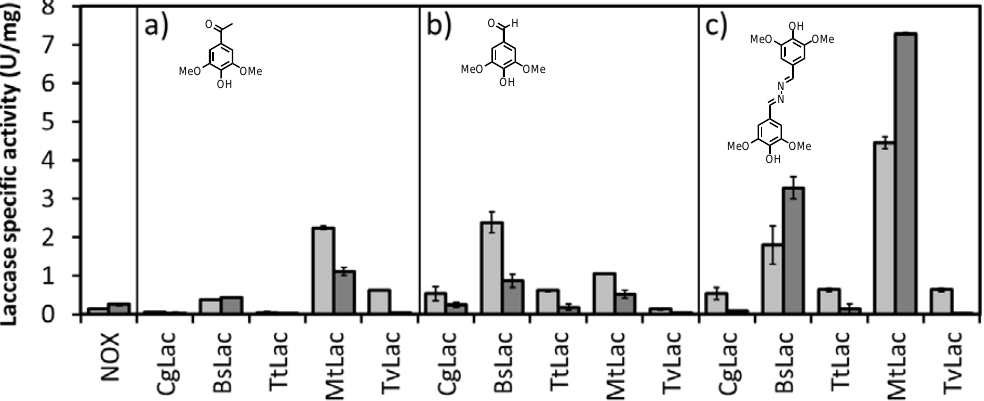
Figure 2. Screening of different laccases in combination with ( a ) acetosyringone, ( b ) syringaldehyde and ( c ) syringaldazine. The activities of the different laccase/mediator systems were spectrophotometrically assayed at pH 5.0 (light grey) and pH 8.0 (dark grey) following the decrease of absorbance at 340 nm (NADH oxidation). Activity of NOX in presence of 0.5 mM NADH at pH 5 and pH 8 is reported in the firsts two columns. Laccases from Casuarina glauca ( Cg Lac), Bacillus subtilis ( Bs Lac), Trametes trogii ( Tt Lac), Myceliophthora thermophila ( Mt Lac) and Trametes versicolor ( Tv Lac) were used.